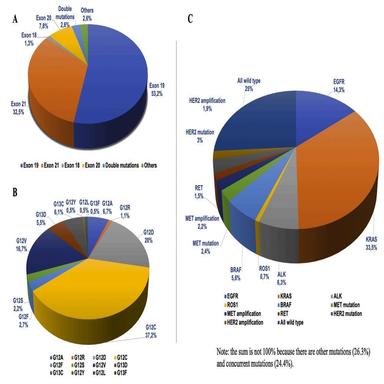
1.A) Frequencies of different types of EGFR mutations. 1.B) Frequencies of different types of KRAS mutations. 1.C) Frequencies of most common gene alterations detected with NGS.